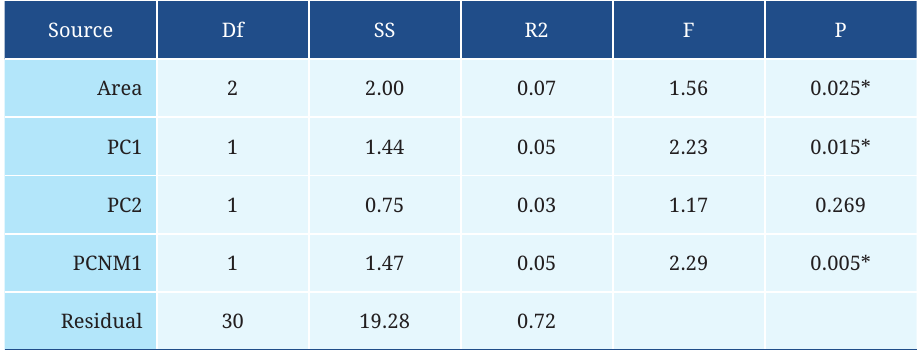
TABLE 5 | Dark diversity ANOVA table. Source: Area type (Area), environmental principal